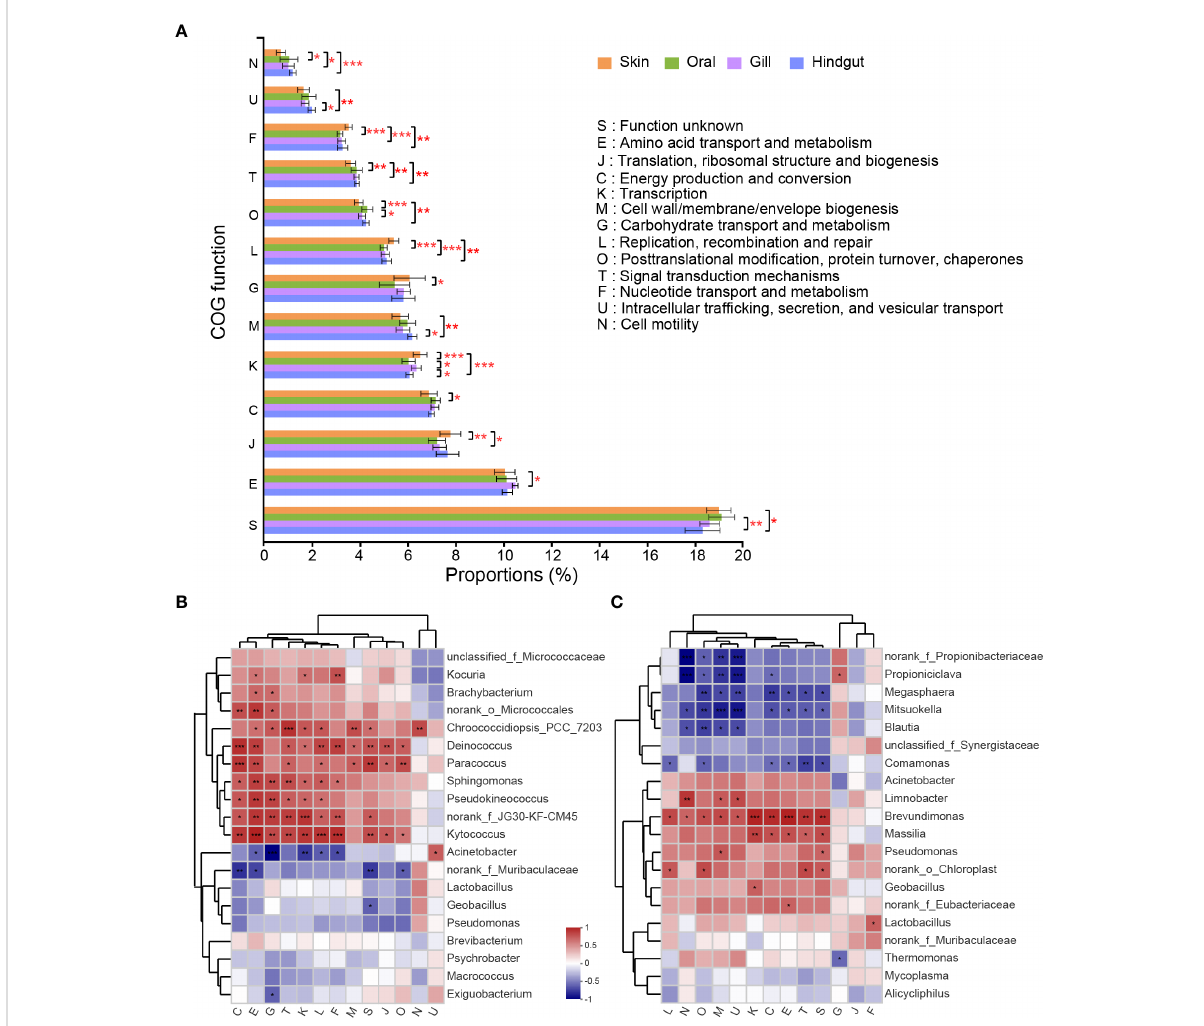
FIGURE 6 COG function classi fi cations with a signi fi cant difference in the four groups and its correlation with high abundant species. (A) Statistical test of the COGs relative abundance was carried out by the Kruskal-Wallis H Test followed by Bonferroni correction. Heatmap for correlation between COG function classi fi cations and top 20 high abundant species in the (B) skin and (C) hindgut. Correlation coef fi cients were calculated by Spearman. (* p ≤ 0.05; ** p ≤ 0.01; *** p ≤